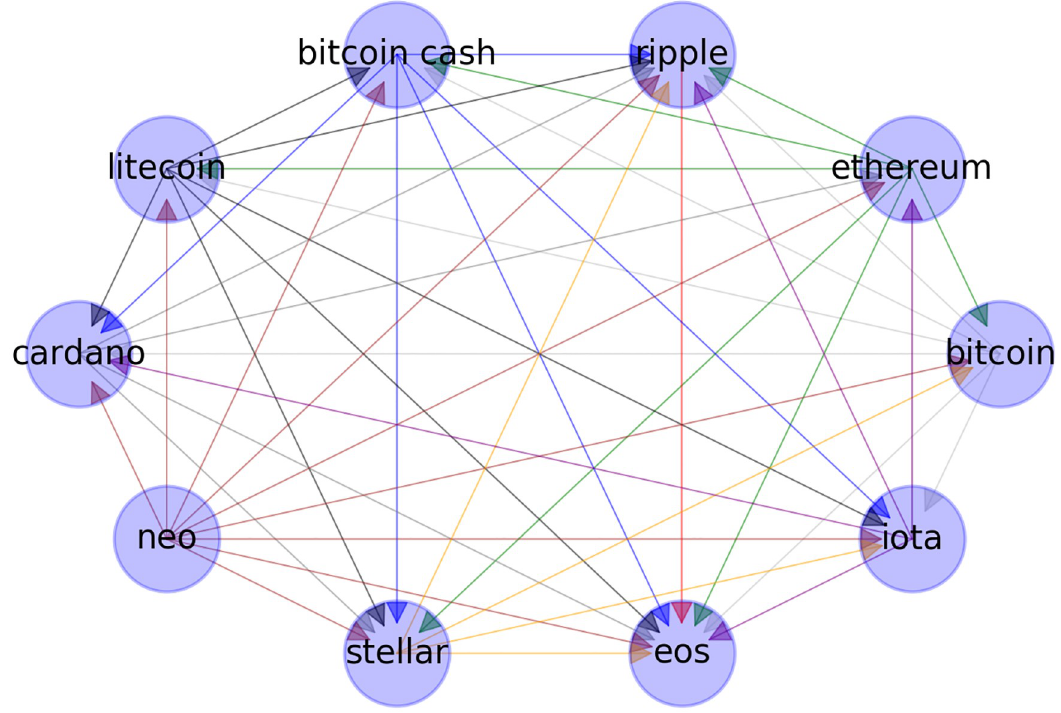
Fig 4. NDI subgraph. The arrow direction represents the direction of the information flow.